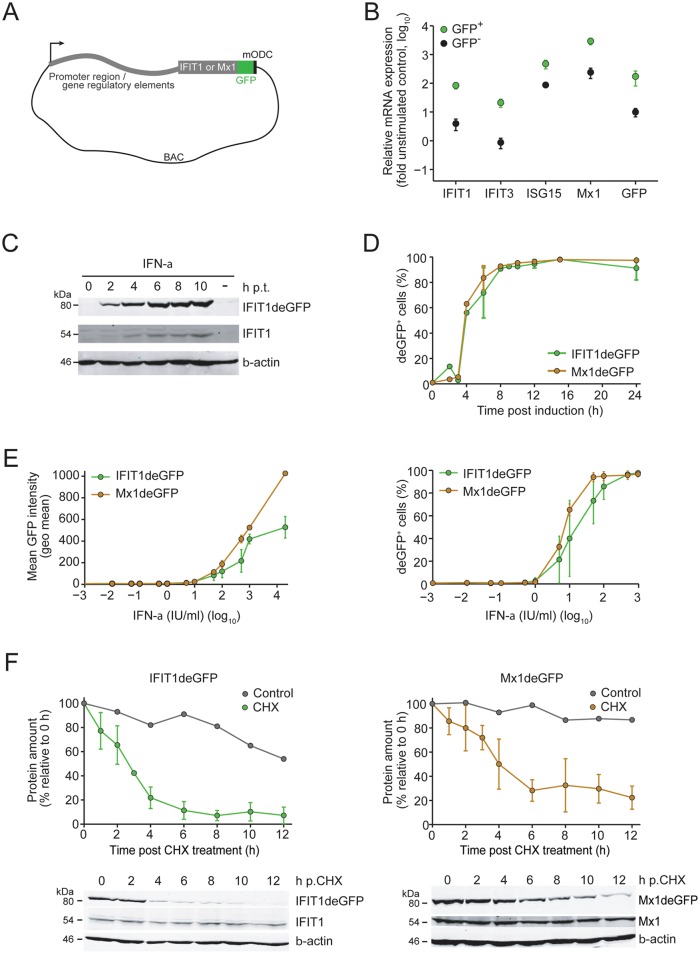
Characterization of stable BAC reporter cell lines.(A) Schematic of the BAC reporter construct. Destabilization of the Mx1deGFP or IFIT1deGFP fusion protein was achieved by C-terminal fusion with the degradation domain of mouse ornithine decarboxylase (mODC). (B) A549-IFIT1deGFP cells were stimulated with 10 IU/ml IFN-α for 24 h and subjected to FACS to separate cells according to expression of IFIT1deGFP. Right after sorting, GFP-positive and -negative cells were lysed and total RNA was extracted. Amounts of mRNAs specified in the bottom of the graph were quantified by RT-qPCR and normalized to GAPDH mRNA levels. Note that the IFIT1 specific RT-qPCR detected both the endogenous ISG and the reporter mRNA. Data represent the mean from two independent experiments and their respective SDs. (C) A549-IFIT1deGFP cells were stimulated with 100 IU/ml IFN-α (to achieve high level expression of the endogenous ISG), harvested at time points specified in the top (hours) and analyzed by Western blot to detect proteins specified in the right. A representative blot from 3 independent experiments is shown. Mock-treated cells are shown in the right lane of each panel. (D) Induction kinetics of IFIT1deGFP and Mx1deGFP after stimulation of A549 reporter cell lines with IFN-α. Cells were treated with 100 IU/ml of IFN-α, harvested at time points specified in the bottom of the graph and number of GFP-positive cells was determined by flow cytometry. Data are mean from 3 independent experiments and their respective SDs. (E) IFN-α dose response assay with A549 reporter cell lines. Cells were stimulated for 24 h with 100 IU/ml IFN-α and analyzed for mean GFP intensity (left panel) or number of GFP-expressing cells (right panel) by using flow cytometry. Data are mean from 3 independent experiments and their respective SDs. (F) Half-life of IFIT1deGFP (left panel) and Mx1deGFP (right panel) as determined by CHX treatment of cells after pre-stimulation with 100 IU/ml IFN-α for 15 h. Cells were harvested at time points given in the bottom of the graph and cell lysates were analyzed by Western blot using GFP-, IFIT1-, Mx1- and β-actin-specific antisera. Representative blots are shown in the bottom of each panel; quantifications from 4 independent experiments and their respective SDs are depicted in the upper graphs of each panel. In panels C and F, numbers in the left of Western blots refer to molecular weights of size standards in kiloDalton (kDa), respectively.